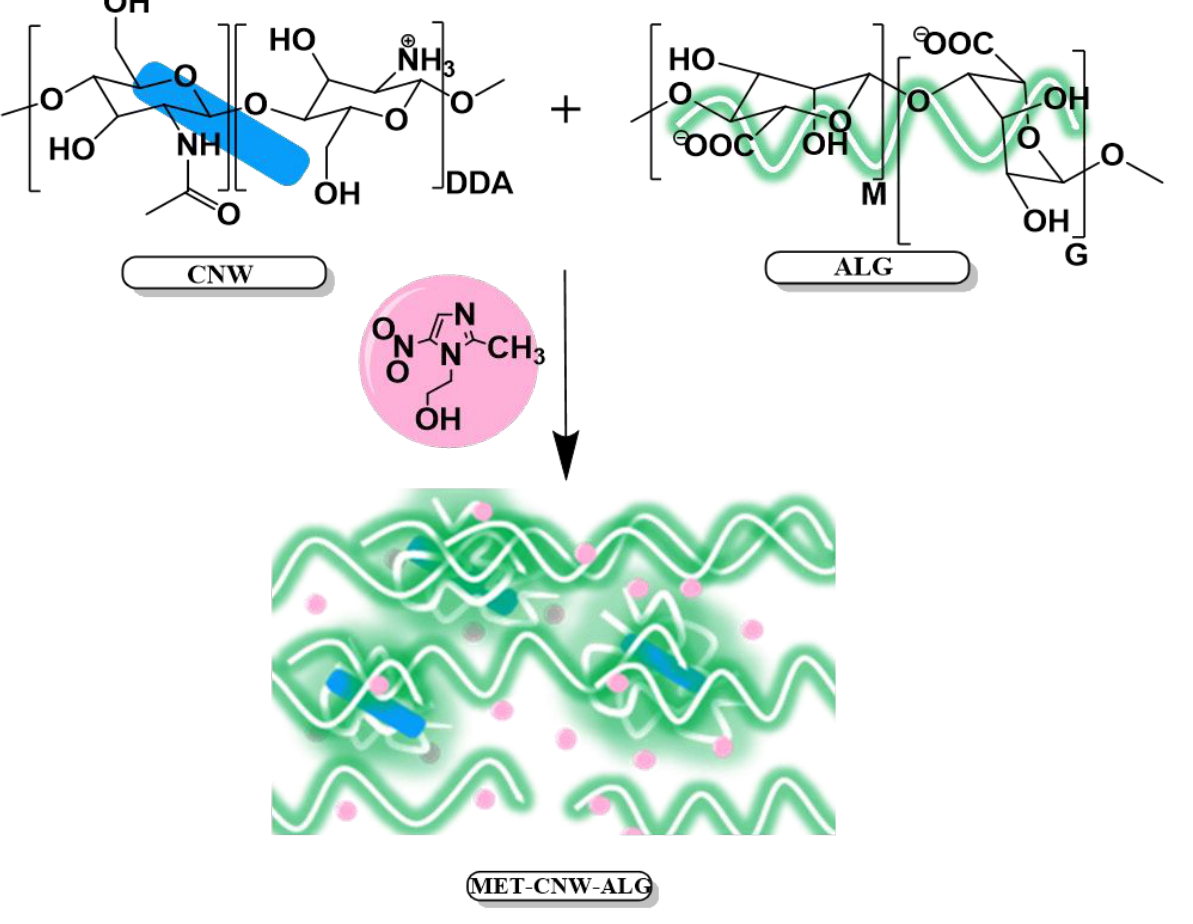
Figure 1. Formation of MET – CNW – ALG hydrogels.